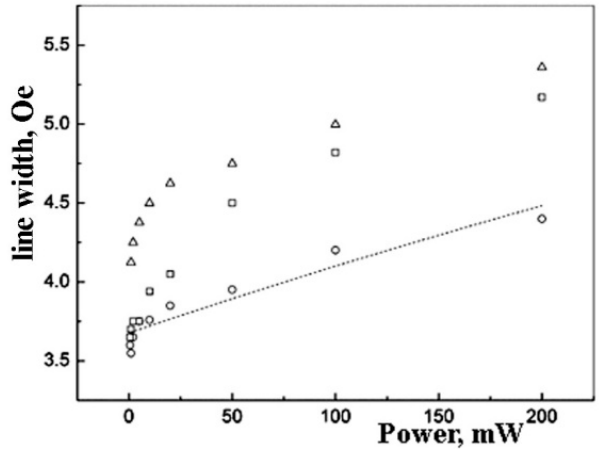
Figure 5. Linewidth saturation curves for experimental EPR spectra for the Pd nanoparticles in polyethylene for the concentrations of 5 wt.% ( ○ ), 10 wt.% ( □ ), and 20 wt.% ( ∆ ). The dotted line showed the approximation by formulae (4) for 5 wt.%.